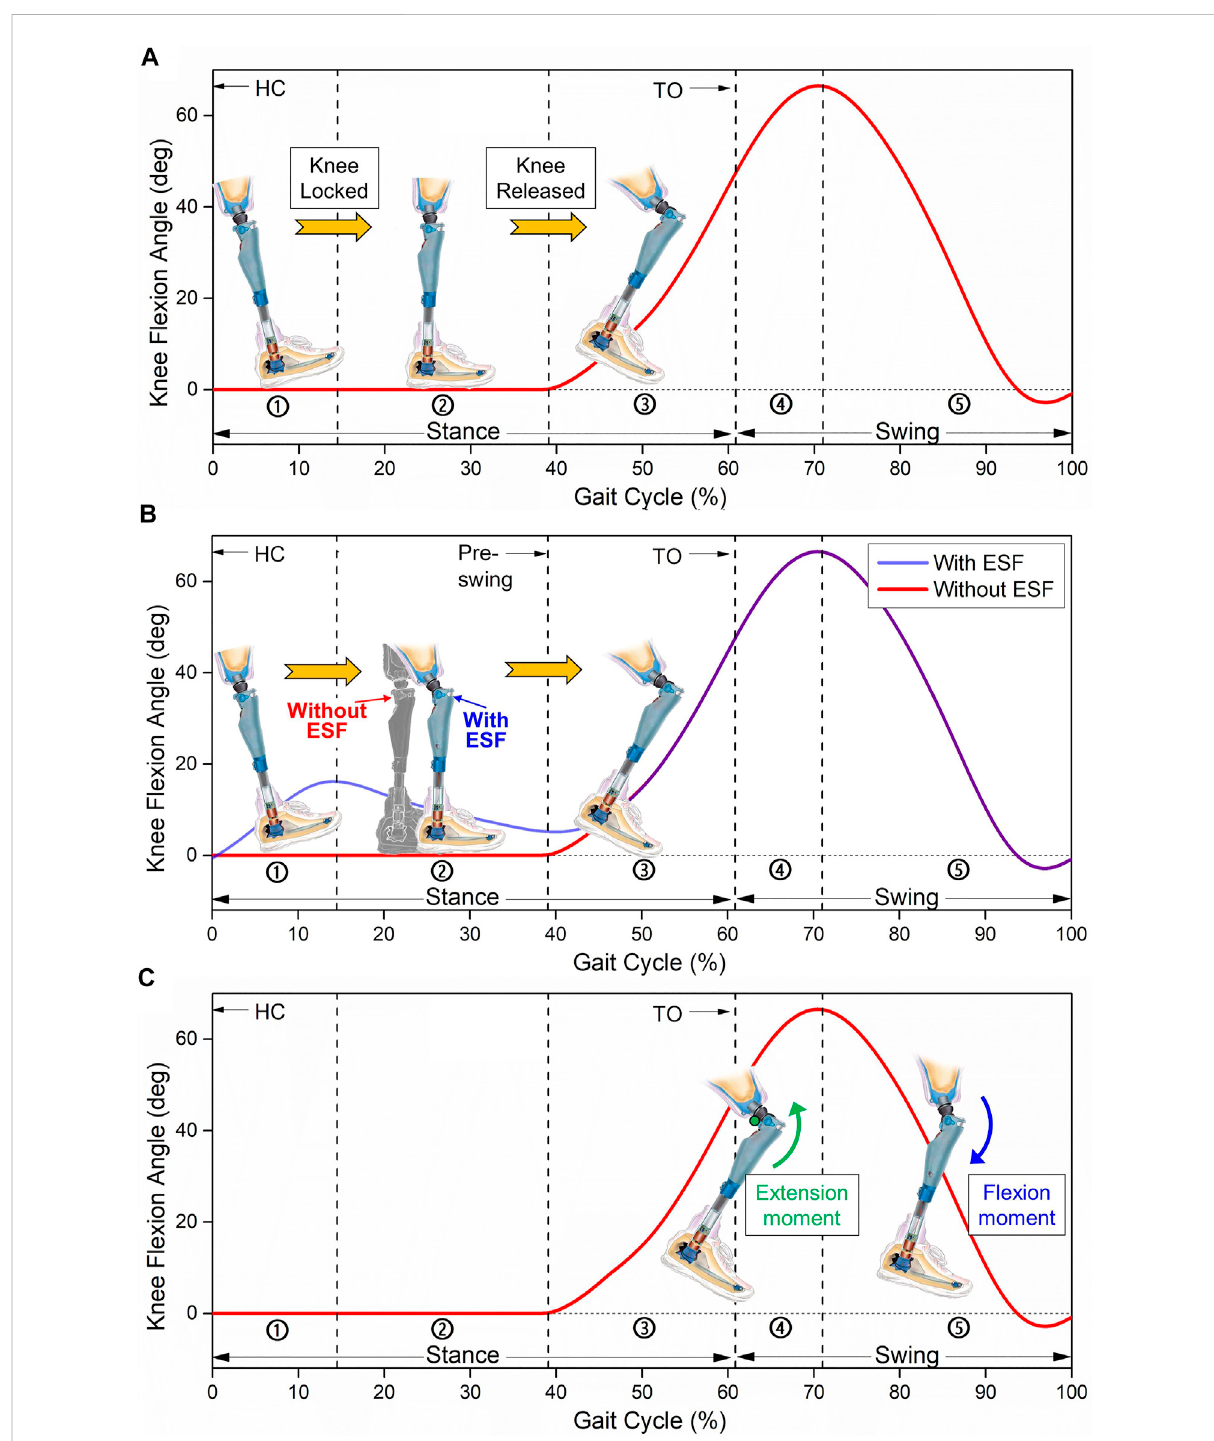
FIGURE 4 Function requirementsofpassive knees. (A) Diagram oftargetknee fl exion angleand statesofmonocentrickneeduring stancephase, inwhich the phases from ① to ⑤ represent early stance, middle stance, preswing, early swing, and late swing, respectively. (B) Comparison of prosthetic knees with and without ESF during stance phase. (C) Knee moment required for a smooth yet natural swing